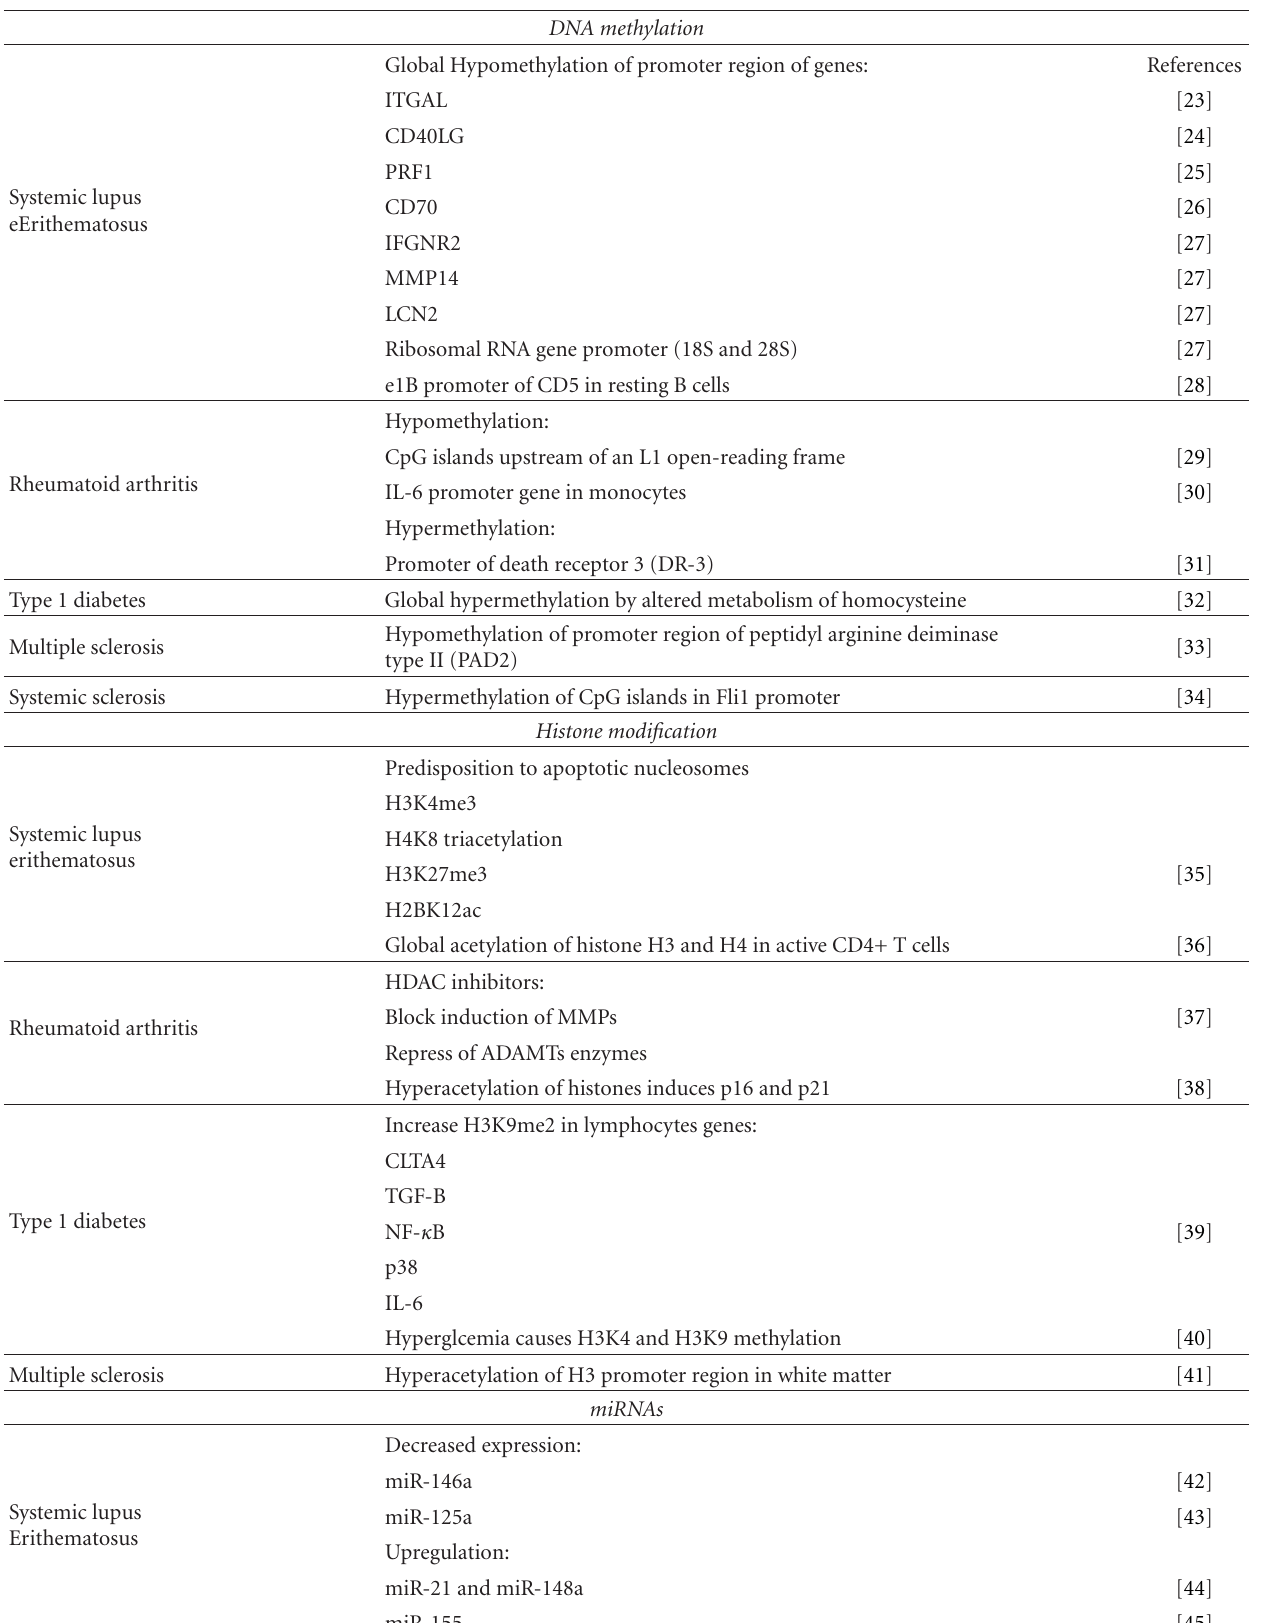
Table 2: Summary of epigenetic mechanisms involved in autoimmune